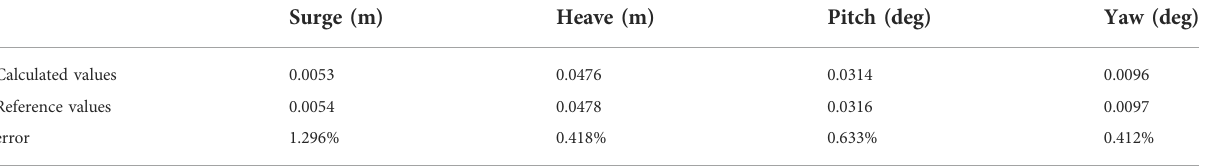
TABLE 2 The natural frequencies of the free decays.